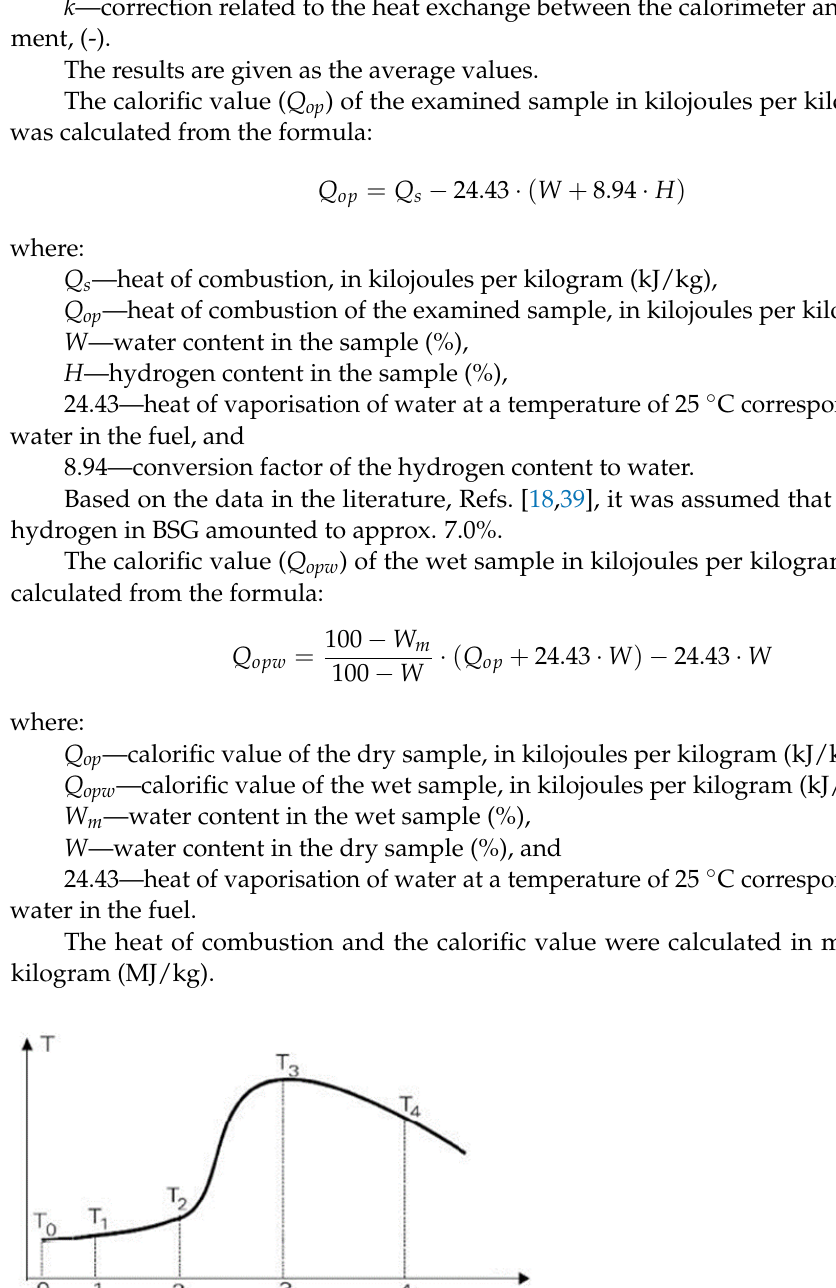
Figure 4. A stand for calorimetric measurements [40]. 4.2.5. Determination of Volatile Matter Content Determination of volatile matter content was performed using the gravimetric method after combustion according to the modification of the method, described by re- searchers [33,41]. The rule of this method consists of the determination of the mass of the fraction in the sample, which escapes as volatile gases (smoke) during combustion at a temperature of approx. 600 °C. The crucible was weighed on the analytical scales CP224S-OCE (Sartorius, Germany) with an accuracy of 0.0001 g (c), and 1 g of the sample of dry spent grain was added to the crucible (a). The crucible was placed in the muffle furnace for combustion SM-2002 (Czylok, Jastrzębie -Zdrój, Poland), heated to a temperature of approx. 600 ± 15 °C, and combusted for approx. 10 min. During the process, smoke coming out of the opening in the upper part of the muffle furnace was observed. The crucible with the desmoked sam- ple was then taken out of the furnace with the help of metal pliers and placed in the exi- cator. After cooling, the crucible with the desmoked residue was weighed on the analytic scales with an accuracy of 0.0001 g (b). The determination was conducted in two replicates. Volatile matter content (VM) (%) was calculated from the formula: VM = [(a−c)− (b−c)]∙100 a−c (8) where: a — mass of the crucible with the sample prior to combustion, in grams (g), b — mass of the crucible with the residue after combustion, in grams (g), and c — mass of the crucible, in grams (g). 4.2.6. Calculation of Fixed Carbon Content